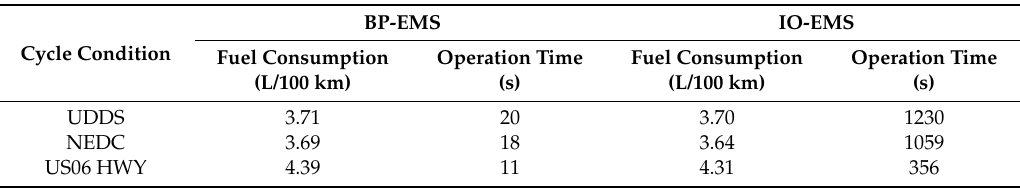
Table 4. Fuel consumption and operation time in two